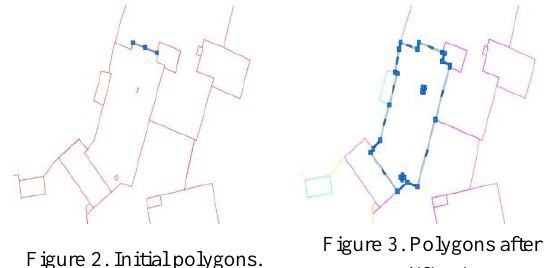
Figure 2. Initial polygons.